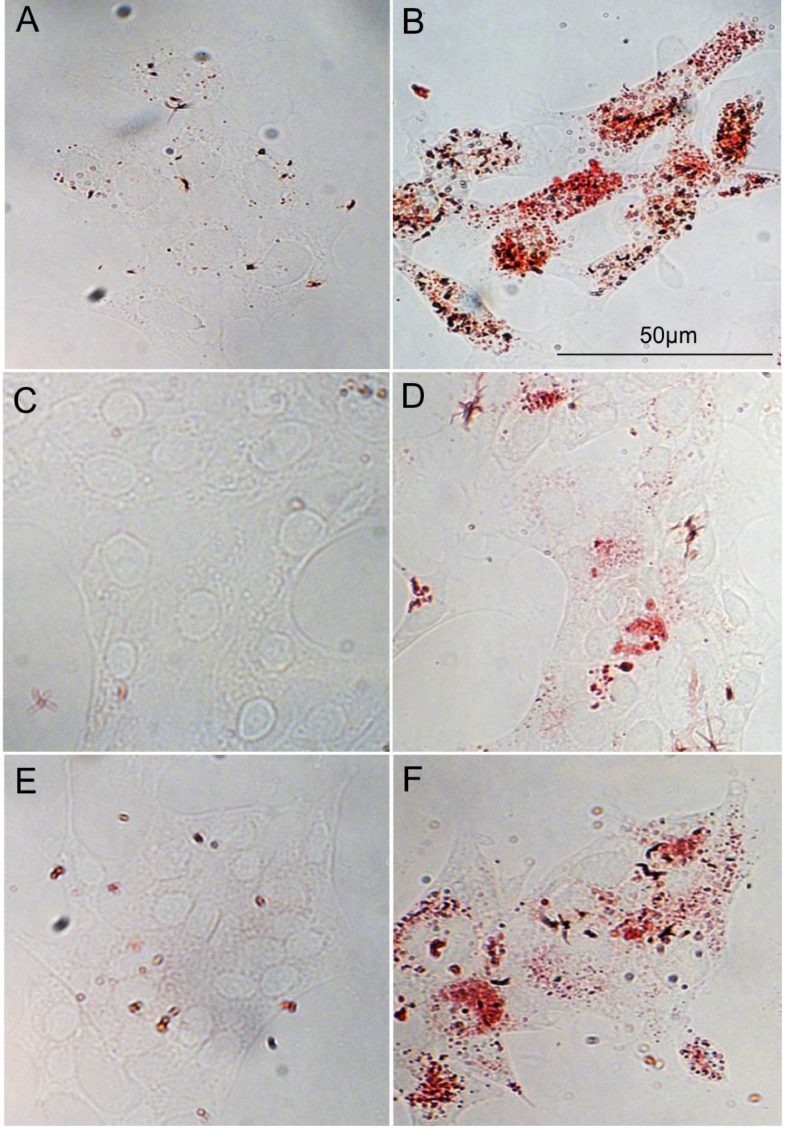
Figure 1. Uptake of oxLDL by HNC cells. ( A , B ) Representative pictures of Oil Red O staining of FaDu cells without oxLDL and with oxLDL, ( C , D ) Detroit 562 cells without oxLDL and with oxLDL and ( E , F ) UPCI-SCC-131 cells without oxLDL and with oxLDL. Cells were colored with Oil Red O after 48 h of oxLDL